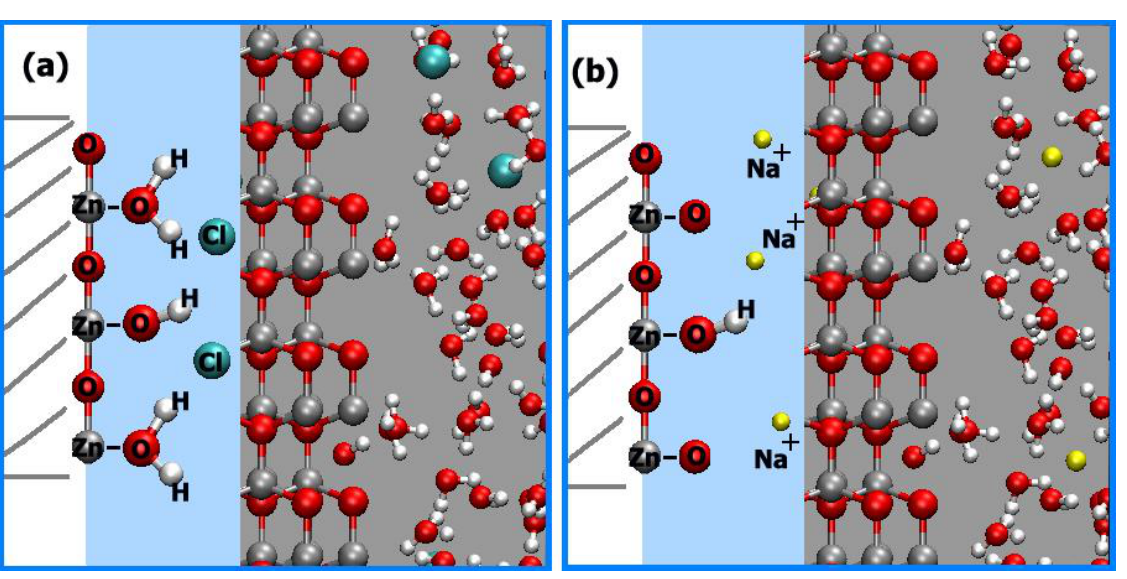
Figure 18. Schematic representation of the distribution of charges due to the slow reaction: (a) at pH < 8.9, (b) at pH >